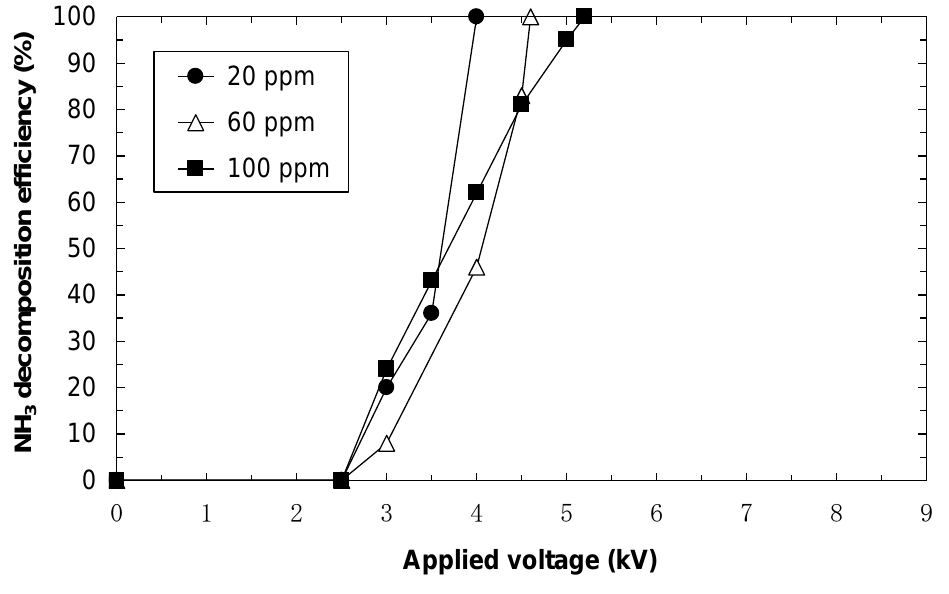
Figure 9. Effect of initial concentration on ammonia decomposition (flow rate = 5.0 L/min, laminated film-type packed-bed plasma reactor).